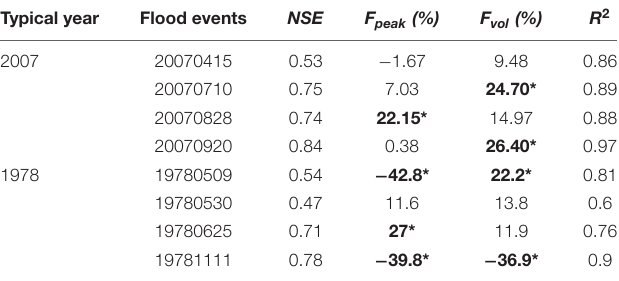
TABLE 4 | Summary of performance of selected flood events in 2007 and 1978 year. Typical year